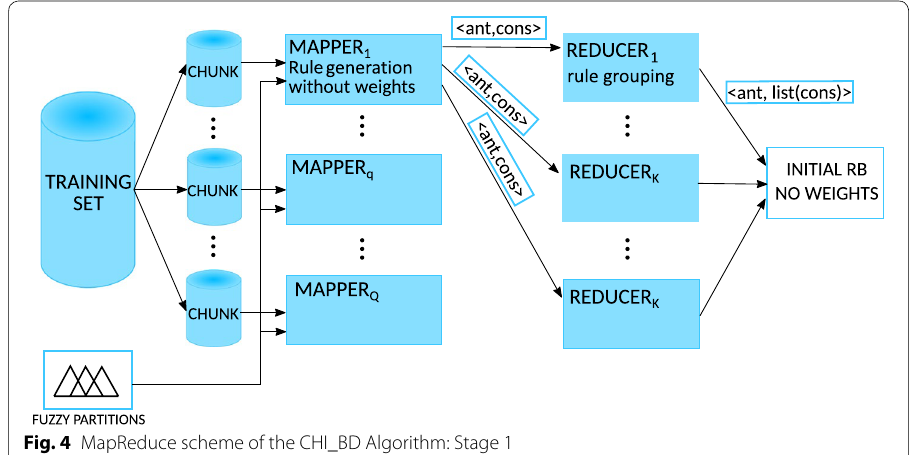
Fig. 4 MapReduce scheme of the CHI_BD Algorithm: Stage